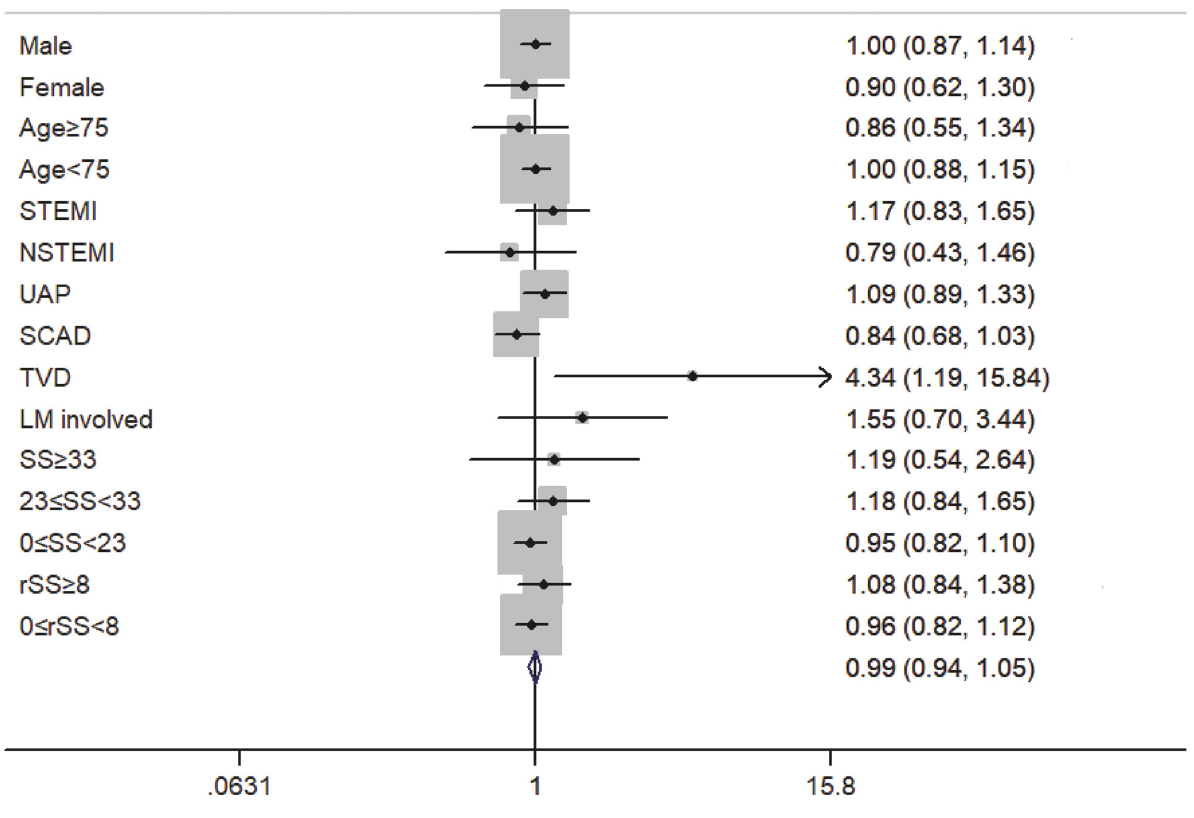
Figure 2: Forest plot of subgroup analysis. The multivariable analysis indicated whether current smoking is associated with 2-year